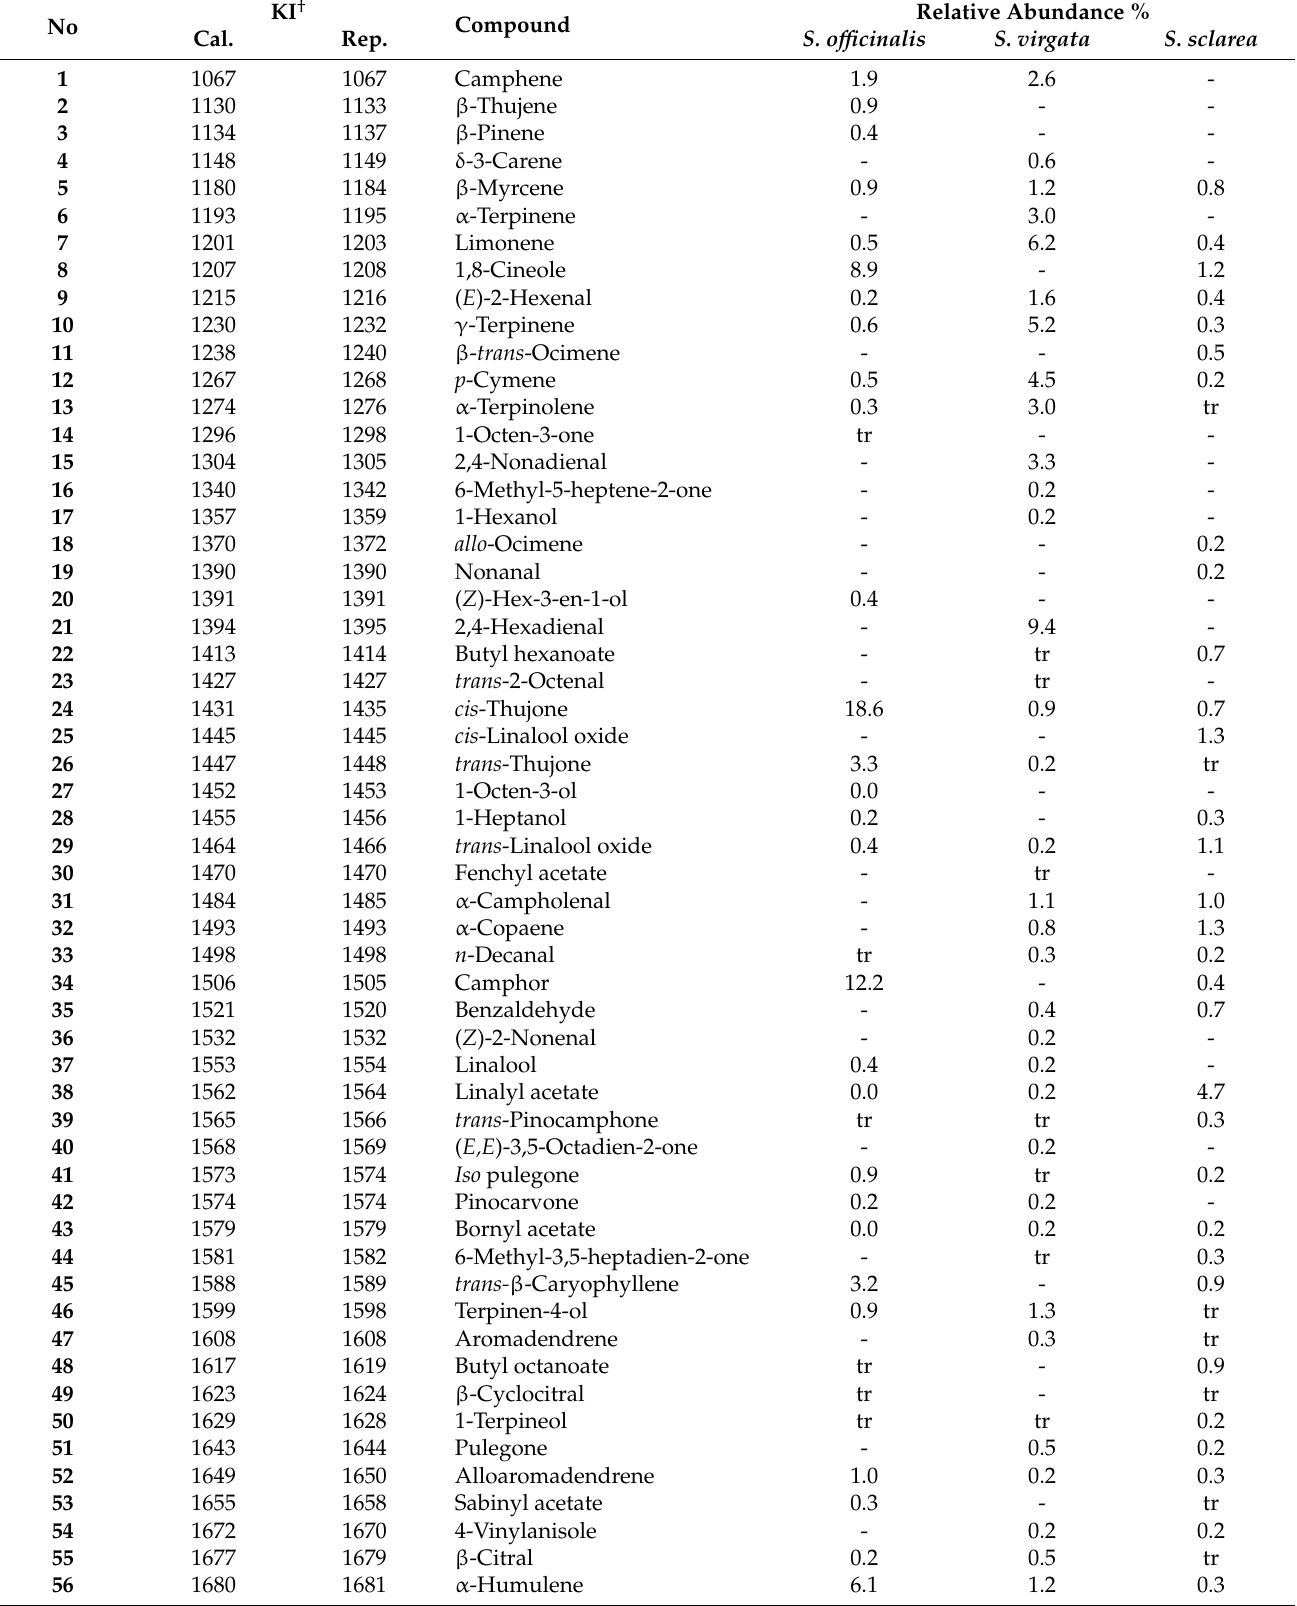
Table 1. Chemical profile of the aerial parts of S. officinalis, S. virgata and S. sclarea essential oils ( n = 3 ±